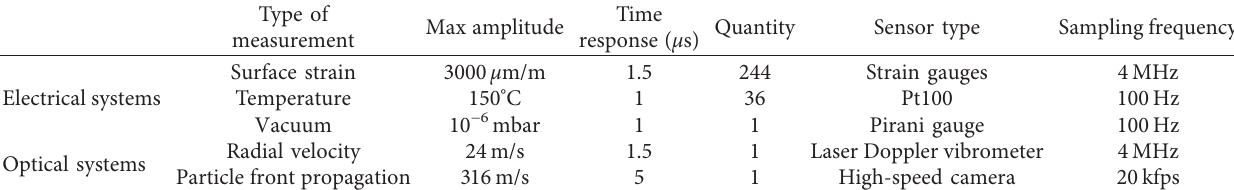
Table 5: Instrumentation requirements.